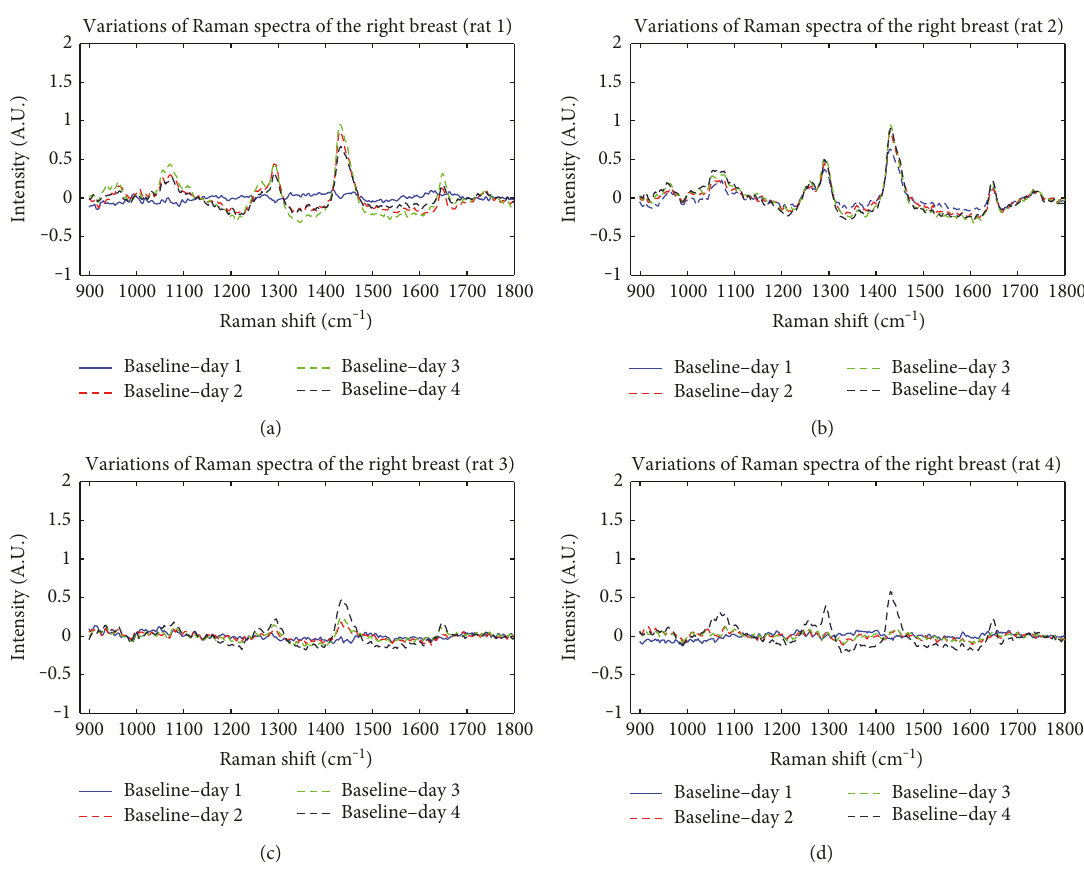
Figure 6: Variations of Raman spectra from rat group with regard to the baseline (baseline means the day high-dose chemotherapy was started). The spectrum for each day was subtracted from the baseline signal. Positive values mean that the intensity was decreased, and the negative values mean that the intensity was increased with respect to the baseline signal. Day n means n day postchemotherapy. Table 2: The tumor volume variation from the three rats in the no chemo